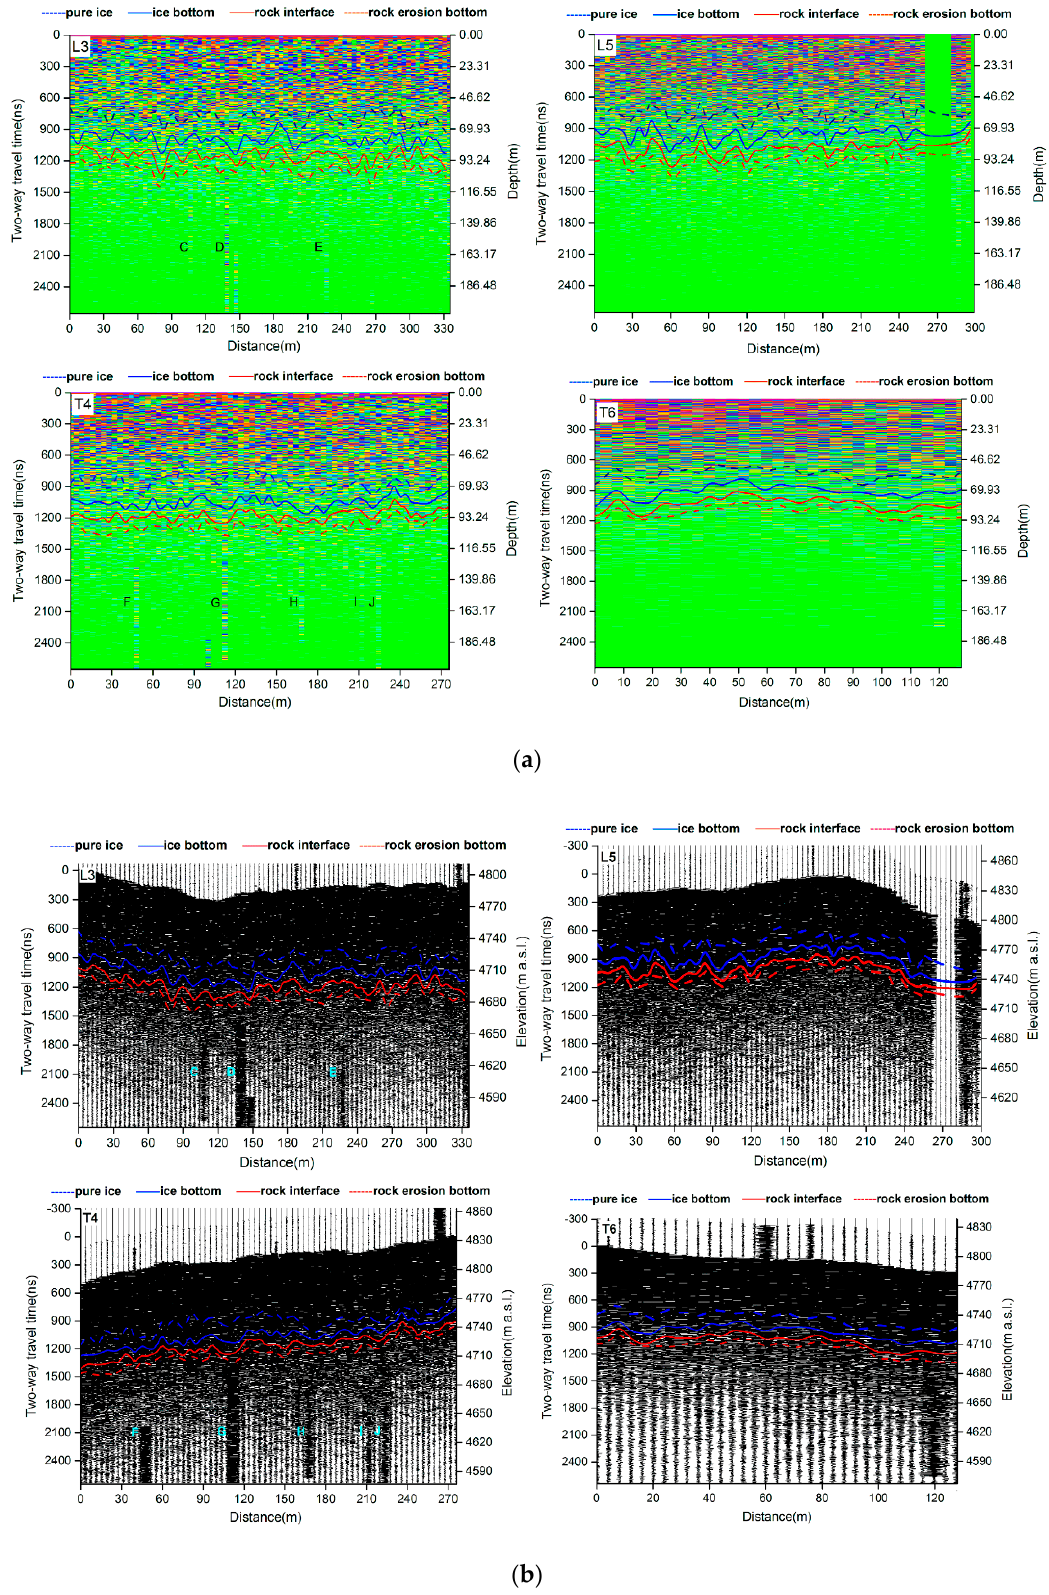
Figure 5. ( a ) The GPR measurement image and interpretation results of the glacier base and bedrock interface of transverse profile L3 and L5 and longitudinal profile T2 and T4 of BRG1. ( b ) The GPR profile image after elevation correction of transverse profile L3 and L5 and longitudinal profile T2 and T4 of BRG1.